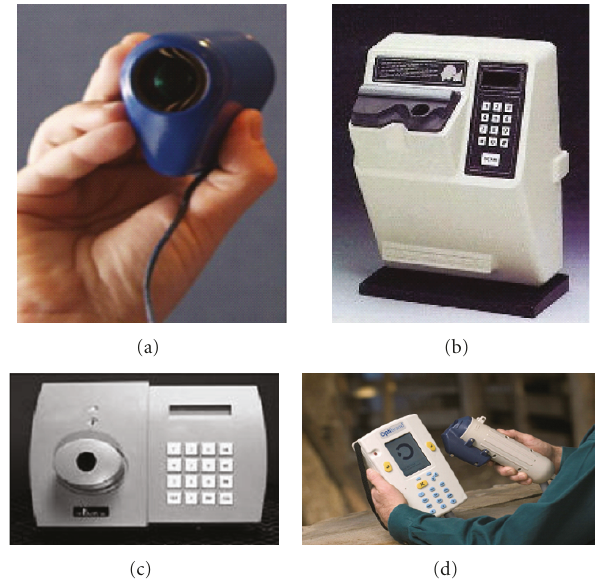
Figure 3: Some retinal scanners, (a) a human retinal scanner,